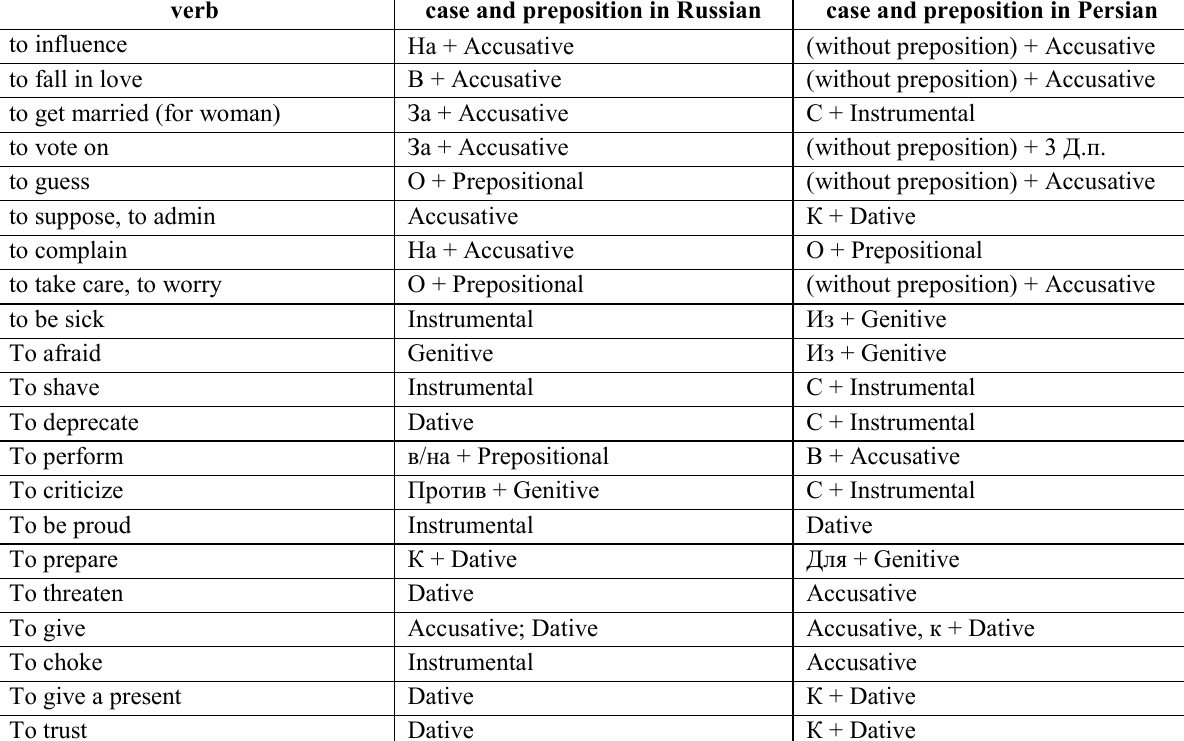
Table 1. – Differences in case use in Russian and Persian